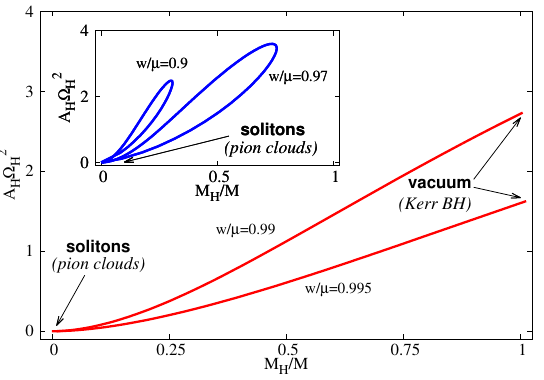
Figure 7 . The dimensionless parameter A H (cid:10) 2 as a function of the hairiness parameter p = M H =M H for spinning BHs with non-topological Skyrme hair, for a coupling constant (cid:11) =